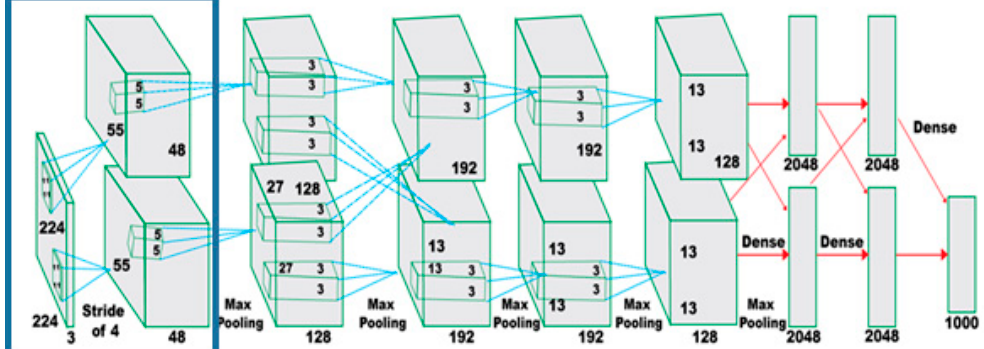
Figure 4. Layer 1 is a convolution layer, the input image size is—224 × 224 × 3 (3 = RGB (8 bits each)), number of filters → 96 (Filter size—11 × 11 × 3) and the layer 1 output comprises of (224/4 × 224/4 × 96 = 55 × 55 × 96) (with a stride of 4 pixels).